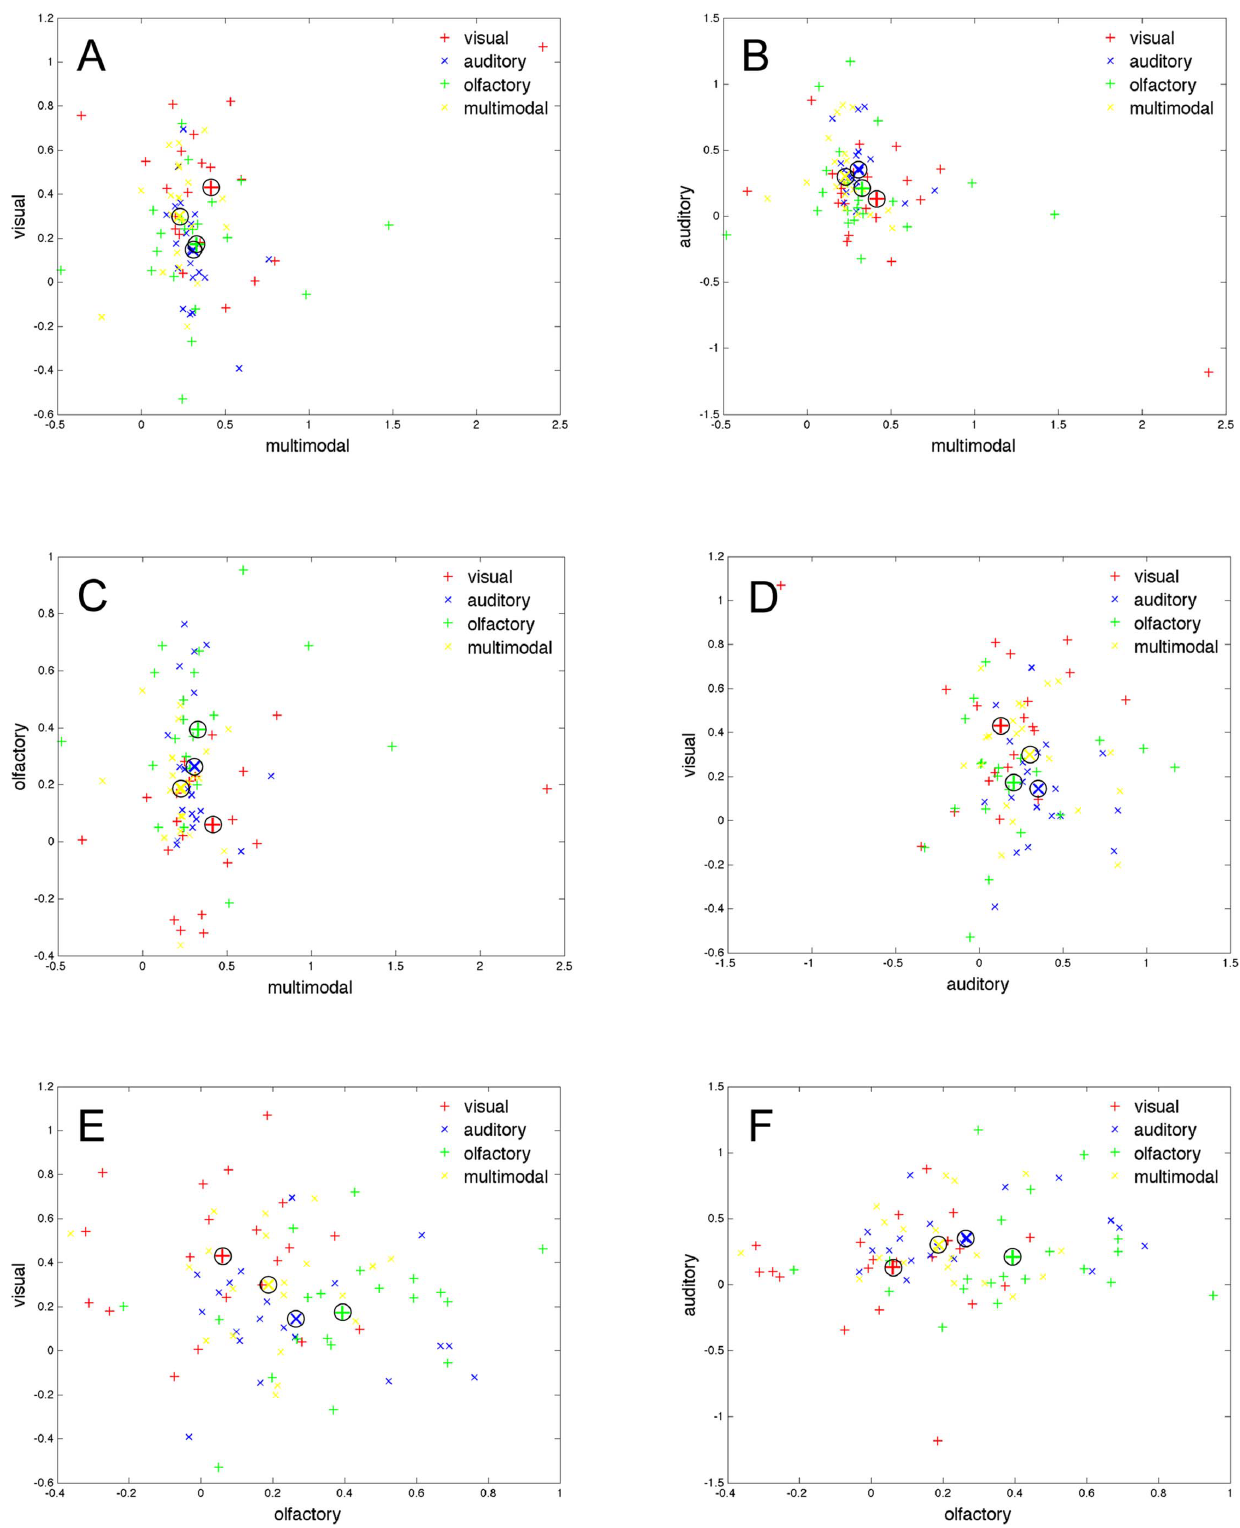
Figure 1. Data-points plotted for all pairwise combinations of the four semantic scales. Note . The axis represents the semantics scales (multimodal, visual, auditory, or olfactory). Panel A–F represent all possible pairwise combinations these scales, e.g., panel A have the multimodal scale on the x-axes and the visual semantic scale on the y-axis. The markers represent the participants’ aggregated narratives on the semantic scale either as red crosses (visual condition), blue crosses (auditory condition), green crosses (olfactory condition), or yellow crosses (multimodal condition). See the methods section for details of how the semantic scales were computed. The four circles represent the mean value for the four conditions.